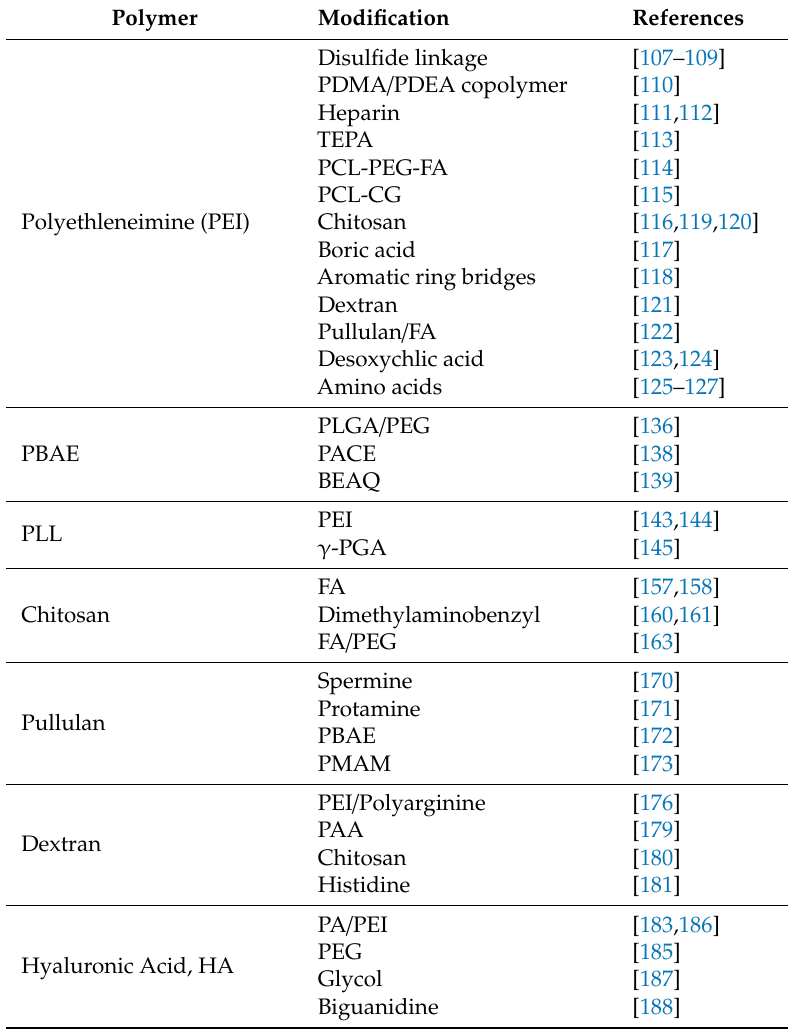
Table 1. Polymer modifications to facilitate biodegradability and / or cellular transport.